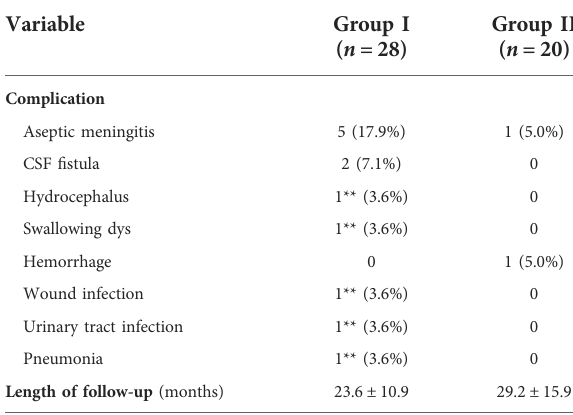
TABLE 1 Clinical or radiological data and management strategies of Group I and II patients ( n